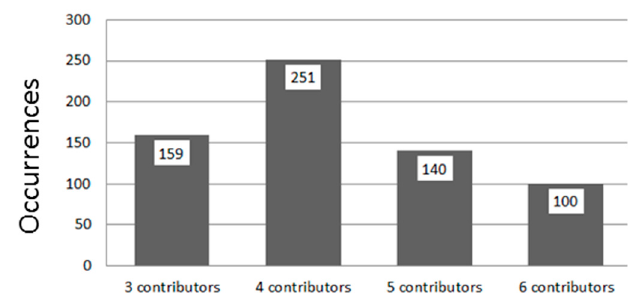
Figure 8. The total number of unique sites of predicted change that was labeled from three to six times in the mapathons.